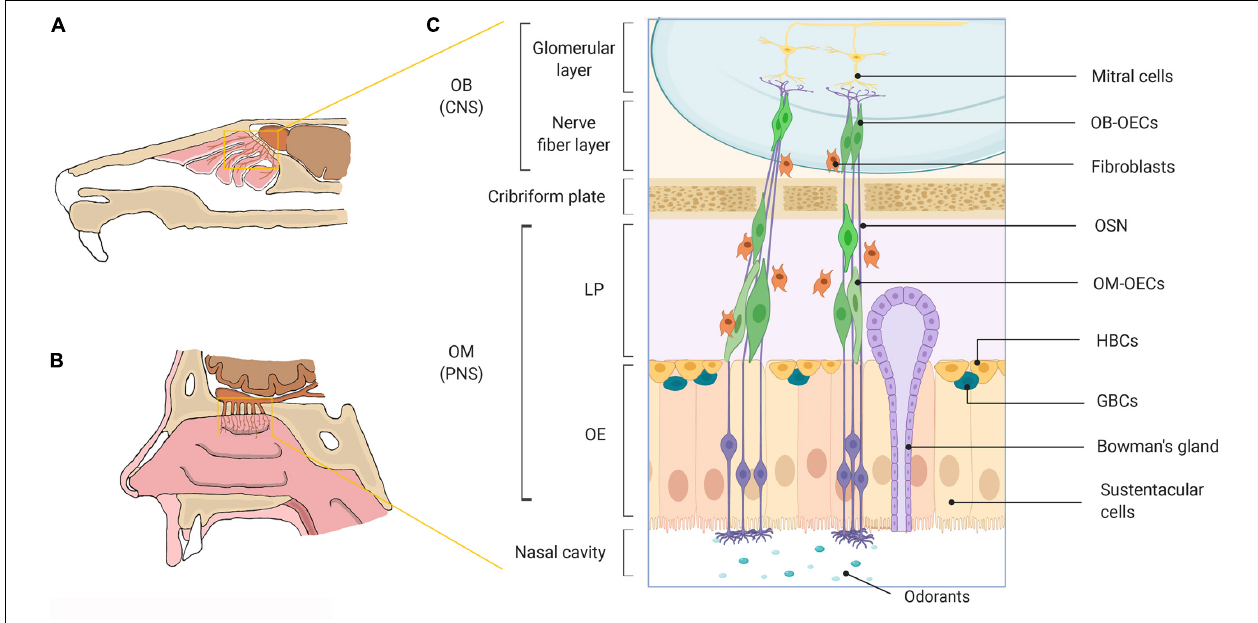
FIGURE 1 | A schematic representation of the olfactory system in mammals. (A) Rodent nasal cavity. (B) Human nasal cavity. (C) A detailed illustration of the major cell constituents of the mammalian olfactory system. OECs can be obtained from the OM lining the nasal cavity located within the PNS and from the nerve fiber layer of the OB, located within the cranial cavity in the CNS. OB, olfactory bulb; OM, olfactory mucosa; CNS, central nervous system; PNS, peripheral nervous system; LP, lamina propria; OE, olfactory epithelium; OECs, olfactory ensheathing cells; OSN, olfactory sensory neuron; HBCs, horizontal basal cells; GBCs, globose basal cells. Created with